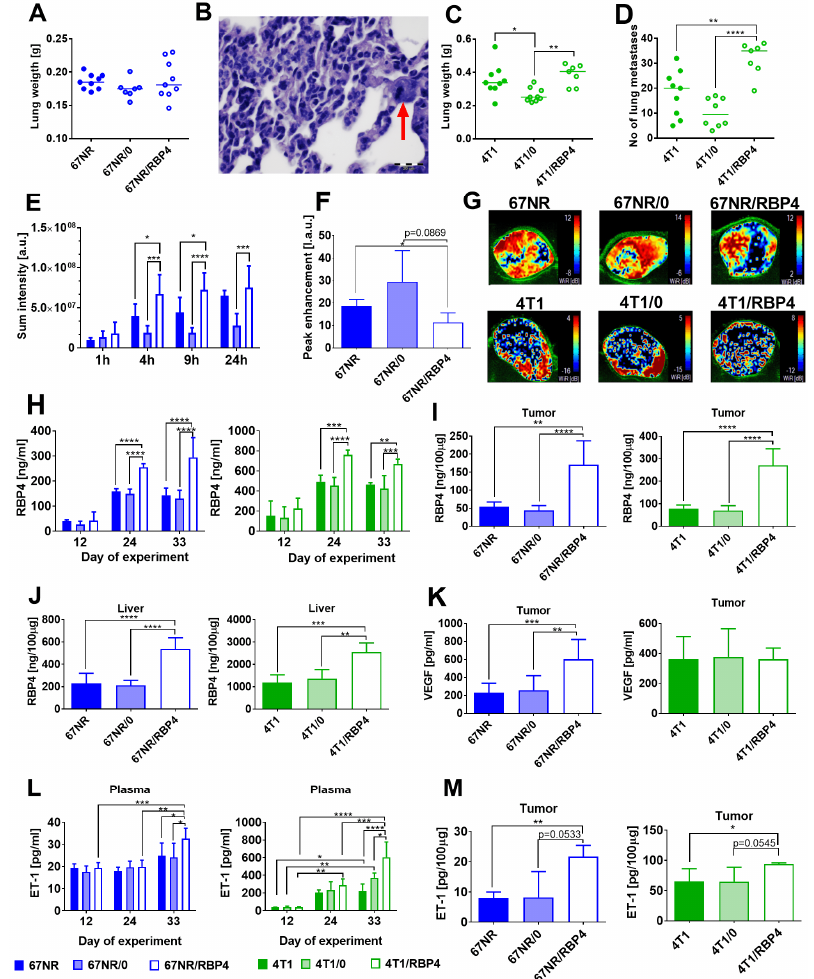
Figure 5. The effect of RBP4 overexpression on metastatic potential and angiogenesis of 67NR and 4T1 tumors. ( A ) Lung weight of 67NR tumor-bearing mice ( N = 7–9) and ( B ) microphotograph of lung metastasis in mice bearing 67NR/RBP4 cells. Red arrow indicates epithelial cell with mitotic spindle. ( C ) Lung weight and ( D ) number of lung metastatic foci in mice bearing 4T1/RBP4 tumors ( N = 7–9). ( E ) Blood vessel permeability in 67NR/RBP4 tumors ( N = 4). ( F ) Peak enhancement in tumor tissue of mice bearing 67NR/RBP4 tumors ( N = 3–4). ( G ) Representative pictures of wash in rate parameter. Concentration of RBP4 protein in ( H ) plasma ( N = 3–5), ( I ) tumor tissue ( N = 5), and ( J ) liver ( N = 5). ( K ) VEGF in tumor tissue ( N = 6–9). Concentration of endothelin-1 (ET-1) in ( L ) plasma ( N = 3–4) and ( M ) tumor tissue ( N = 3–4). Data presented as mean ± SD or data for individual measurements (Figures ( A ), ( C ), and ( D )). Statistical analysis: Tukey’s multiple comparison test. * p < 0.05, ** p < 0.01, *** p < 0.001, **** p < 0.0001.